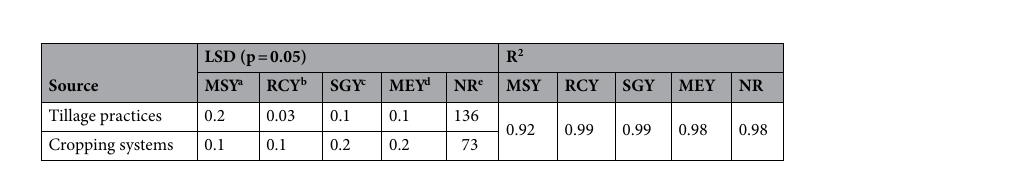
Table 2. ANOVA for a mustard seed yield (Mg ha −1 ), b rainy crops yield (Mg ha −1 ), c system grain